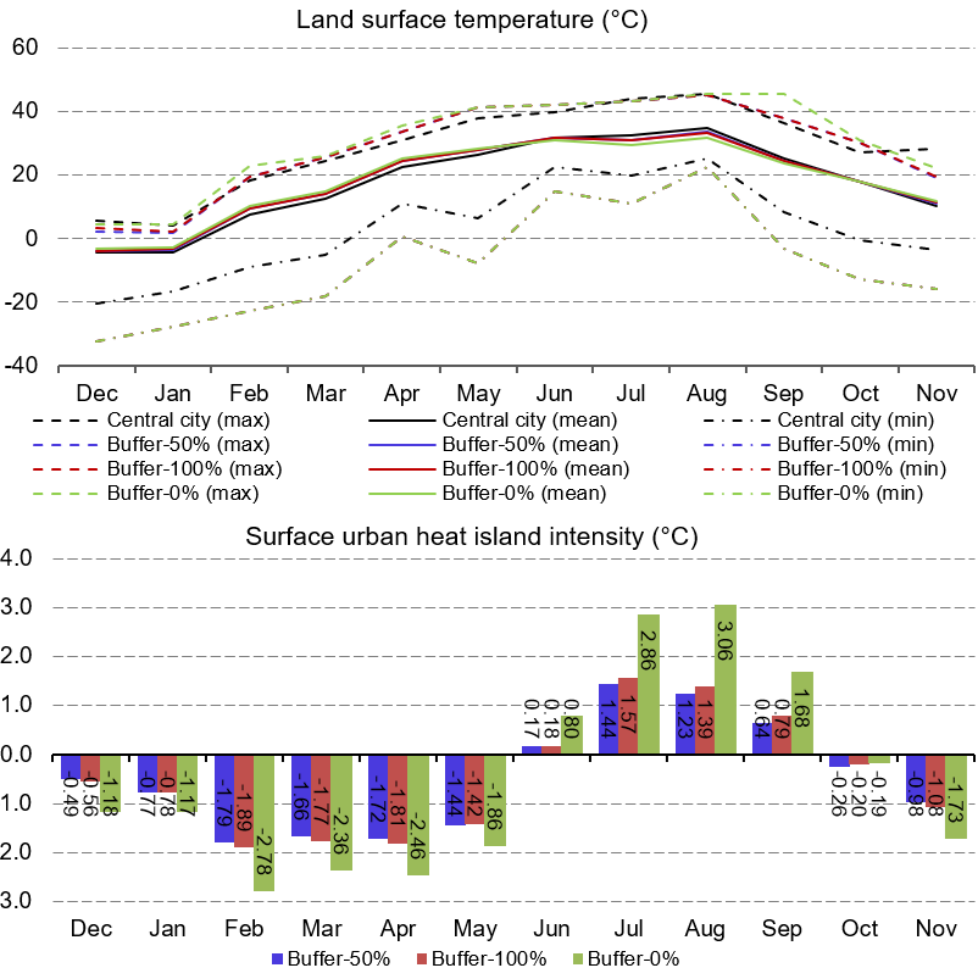
Figure 4. Monthly LST and SUHII variations of the three-ring area in buffer 50%, buffer 100% and buffer 0% scenarios from 2018 to 2020.